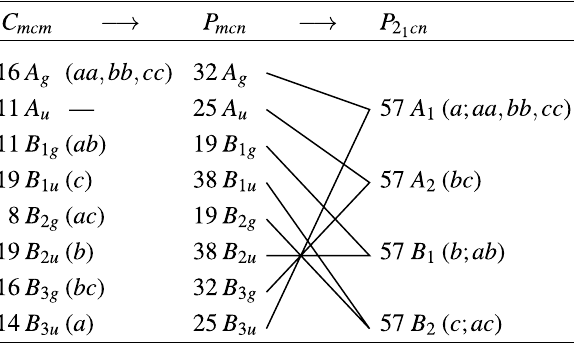
Table 1. Factor group analysis summarizing activities of phonon modes in the three phases of lawsonite (including acoustic